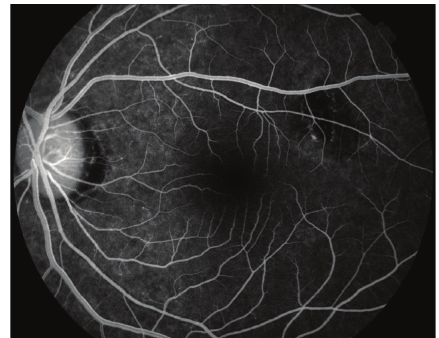
Figure 4: Fluorescein angiography (left